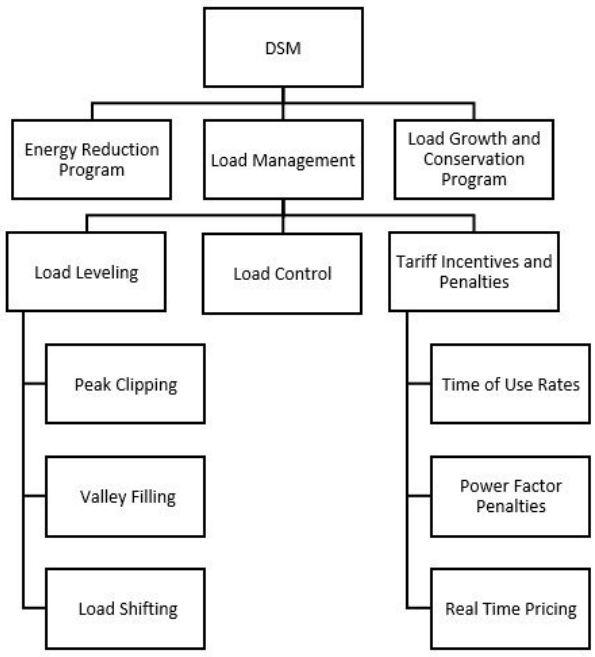
Figure 1. Classification of DSM